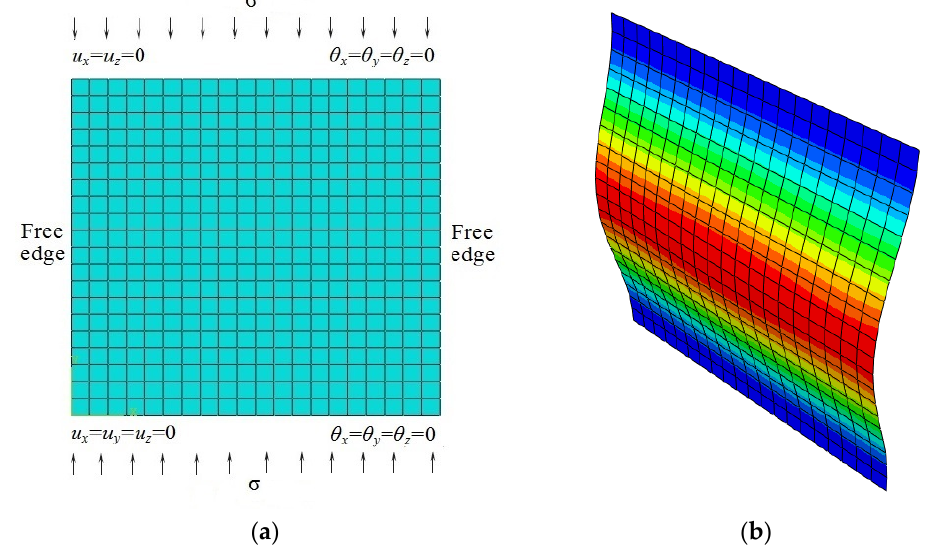
Figure 4. Buckling simulation of an eight-layer symmetric cross-ply laminated rectangular plate ( a ) meshed model (front view) and ( b ) buckled model (isometric view) under free-free-clamped-clamped boundary conditions subjected to stress, σ = 1